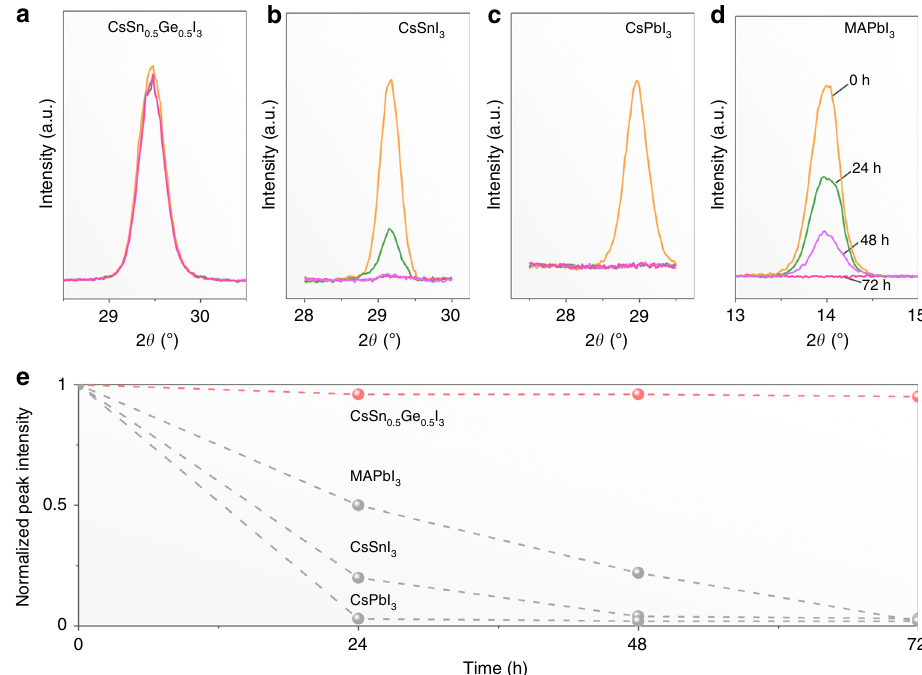
Fig. 3 Thin- fi lm stability. XRD patterns of perovskite thin fi lms before and after exposure for 24, 48, and 72 h to light-soaking (1 sun) at approximately 45 ˚ C and 80% RH: a CsSn 0.5 Ge 0.5 I 3 , b CsSnI 3 , c CsPbI 3 , and d MAPbI 3 . e Plots of relative XRD peak intensities vs . time from a to